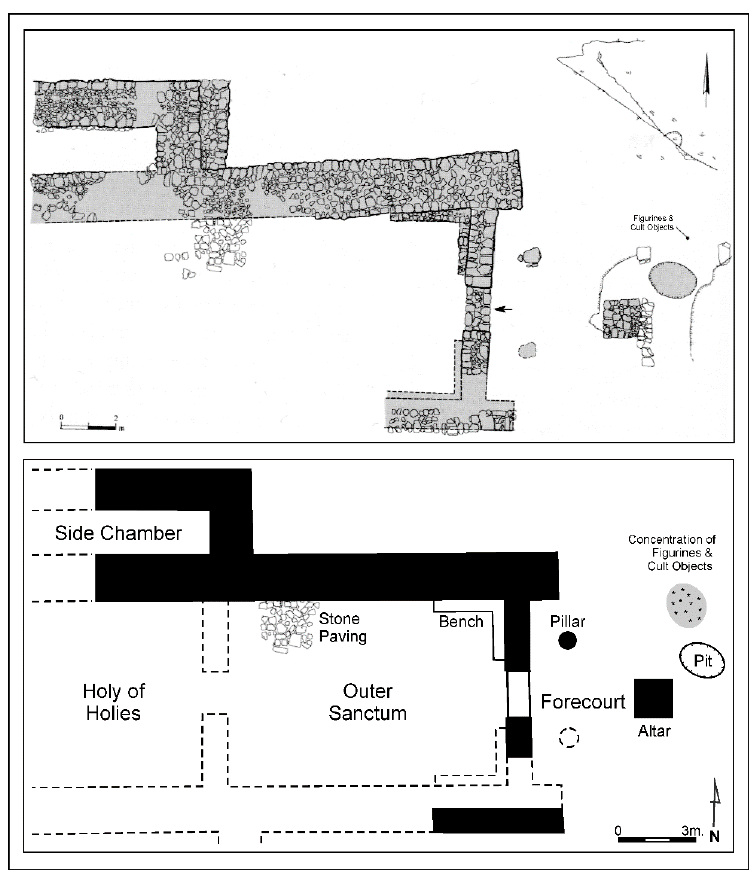
Figure 5. Plan of the remains of the temple (above, Kisilevitz 2015) and our interpretation (below). The plan of the Motza temple is particularly relevant to our subject. Although only part of it is known to us, because the southern side had eroded away down the slope and part of the western